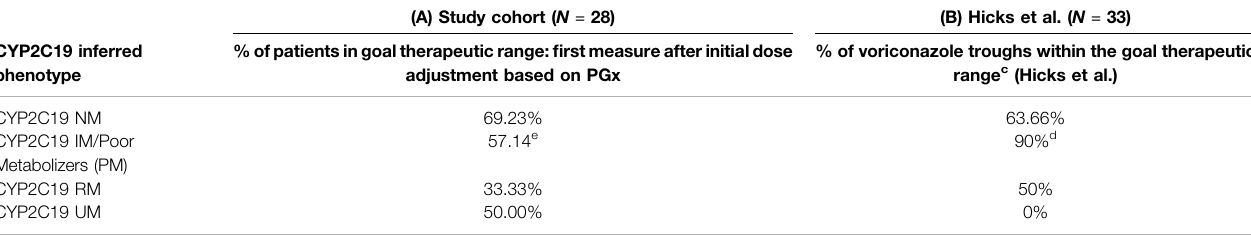
TABLE 4 | Percentage of patients a /troughs b within goal therapeutic range subgrouped by phenotype. Comparison of our results (A) with those found in Hicks et al. ’ s study with standard care (B). All groups of age. (A) Study cohort ( N = 28) (B) Hicks et al. ( N = 33)